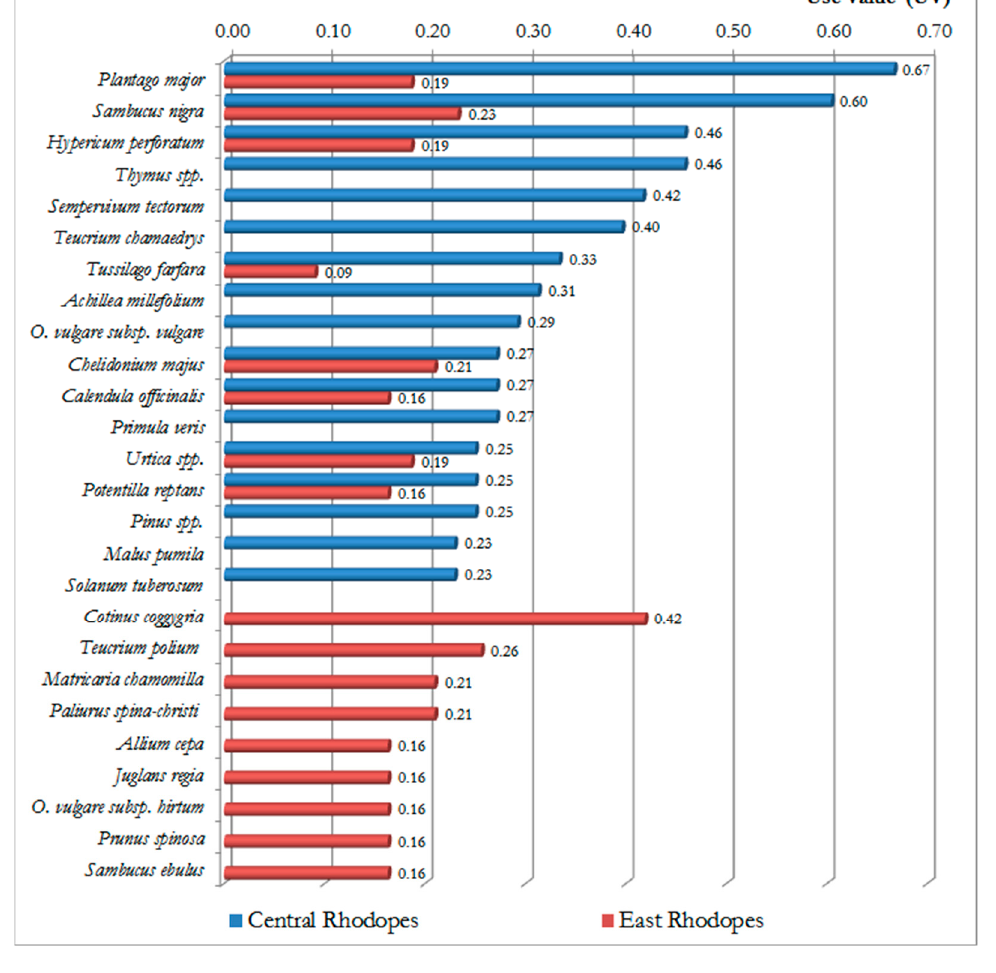
Figure 5. Comparison of plant species by UV index .